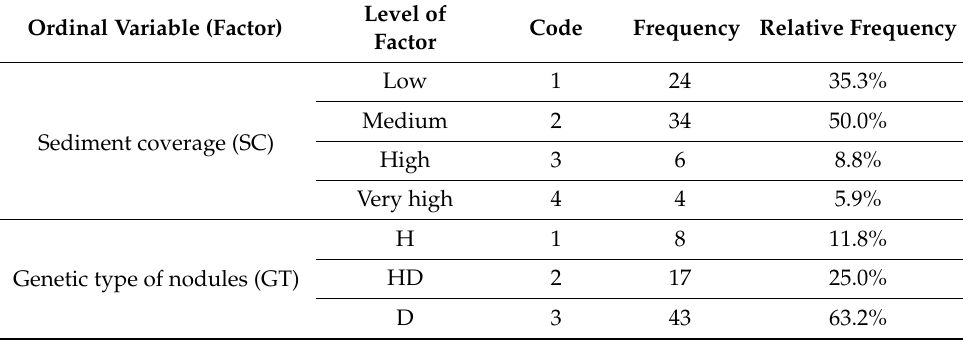
Table 2. Frequency and relative frequency for different levels of factors (ordinal variables): genetic type of nodules (GT), sediment coverage